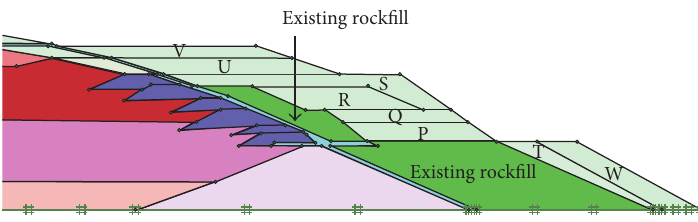
Figure 7: Placement of the rockfill berms P, Q, R, S, T, U, V, and W.